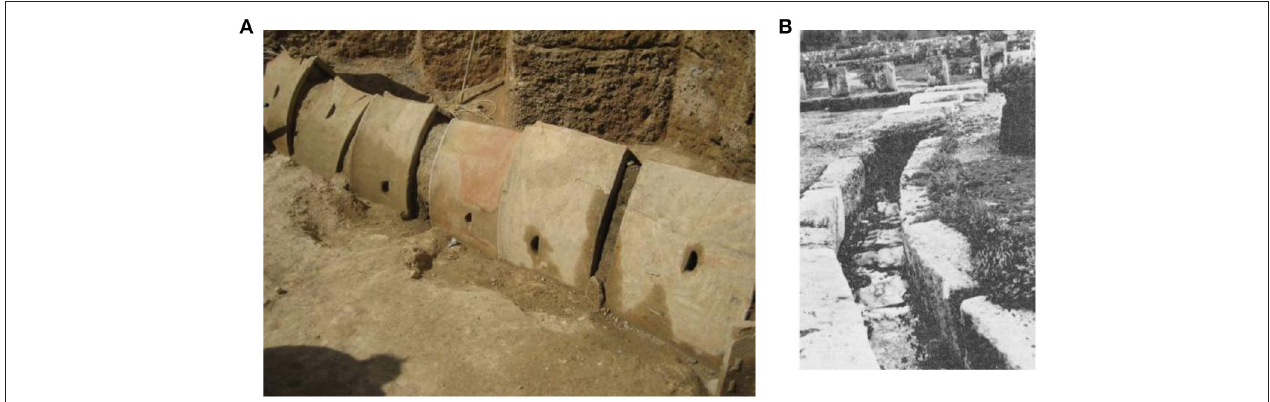
FIGURE 2 | Sewers and drains in ancient Athens used to collect and convey wastewater to central sewer: (A) Clay drain, downhill of Acropolis (with permission of G. Antoniou) and (B) the great drain in ancient Agora (with permission of N. Mamassis).